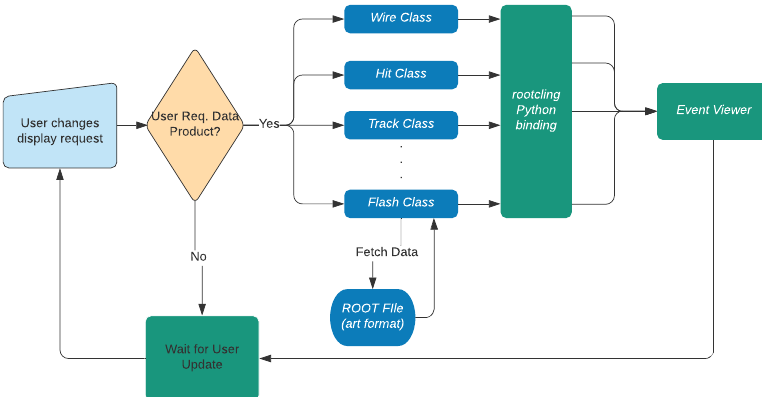
Figure 4. Data processing. The blue part is written in C++, while the green part is in Python